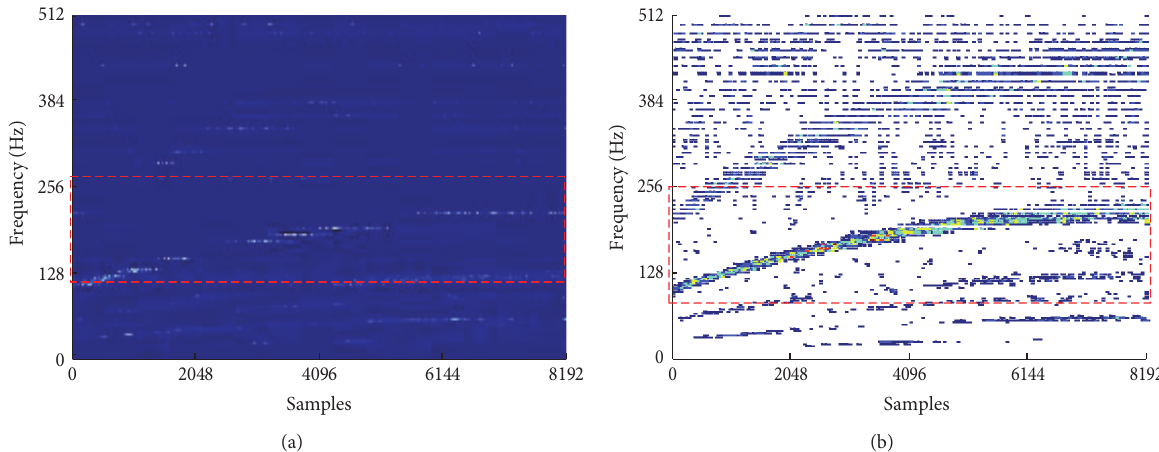
Figure 5: The time-frequency spectrum of the noisy vibration signal obtained with the SST method. (a) The color image display; (b) the contour plot display.